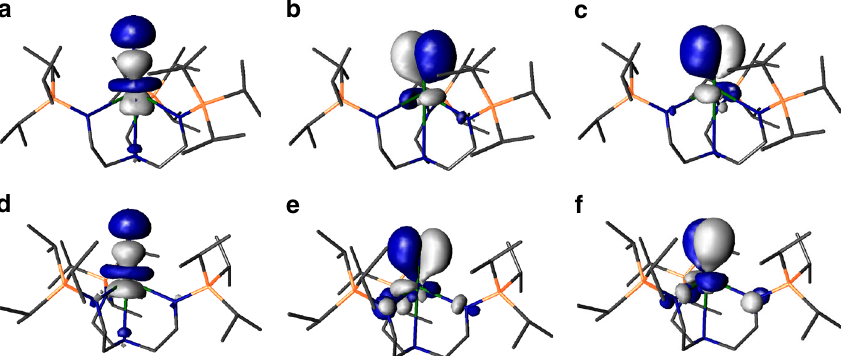
Fig. 6 Frontier molecular orbitals of [M(Tren TIPS )(N)] 2 − (M = Th, 11 ; M = U, 12 ). a HOMO of 11 (221, 3.382 eV), b HOMO − 1 of 11 (220, 2.757 eV), c HOMO − 2 of 11 (219, 2.746 eV), d α -spin HOMO − 2 of 12 (221a, 1.679 eV), e α -spin HOMO − 3 of 12 (220a, 1.215 eV), f α -spin HOMO − 4 of 12 (219a, 1.200 eV). The HOMO (223a, 3.921 eV) and HOMO − 1 (222a, 3.824 eV) in the α -spin manifold of 12 are of essentially pure, non-bonding 5 f orbital single electron character. Hydrogen atoms in these all-electron DFT calculations are omitted from these visualisations for